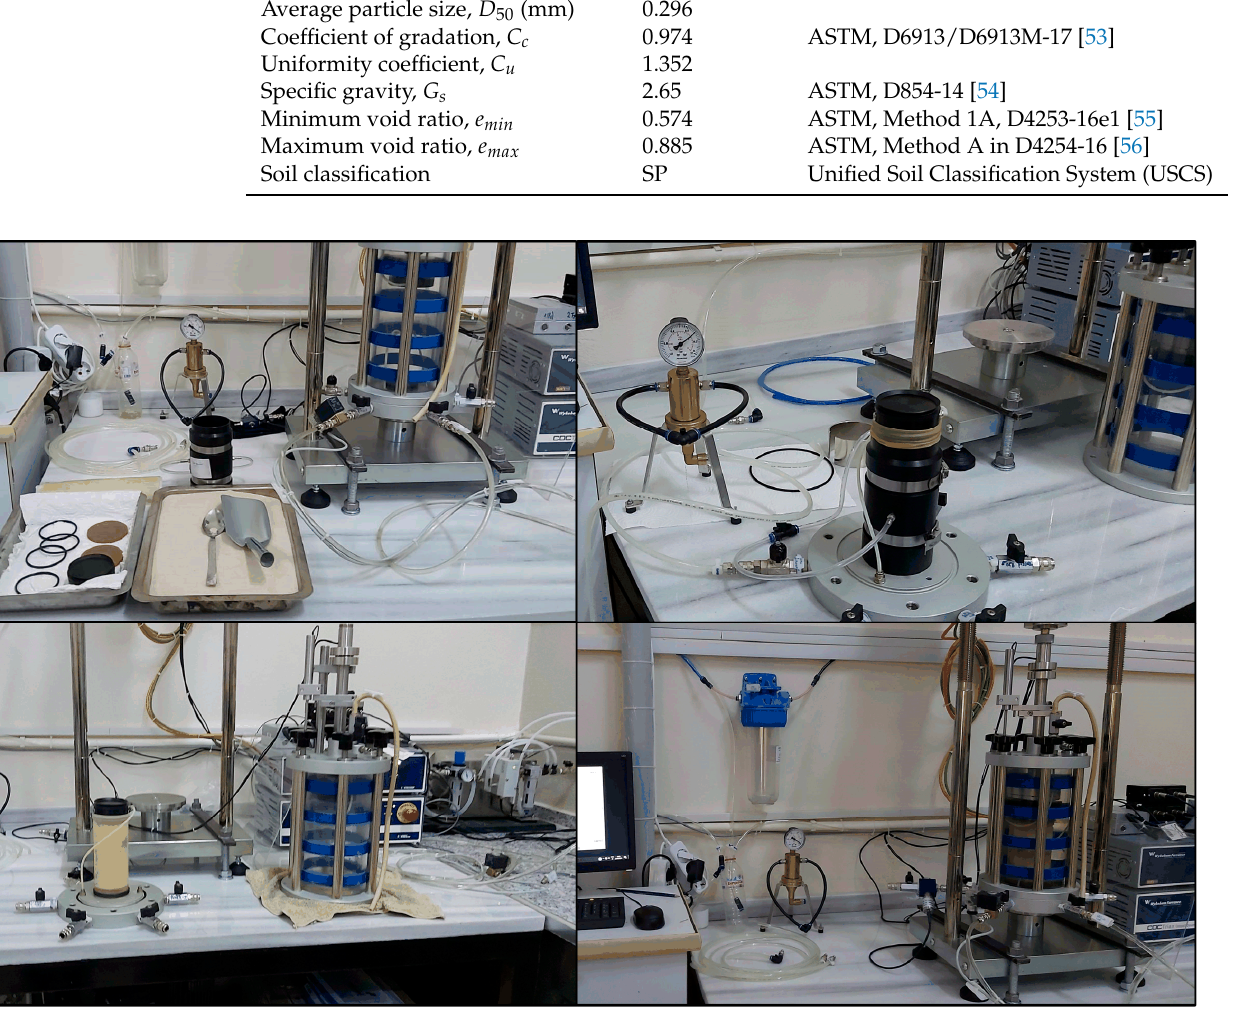
Figure 3. Examples of test images recorded during the specimen preparation.